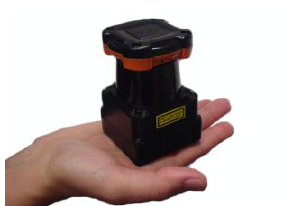
Figure 1. Hokuyo UTM-30LX.